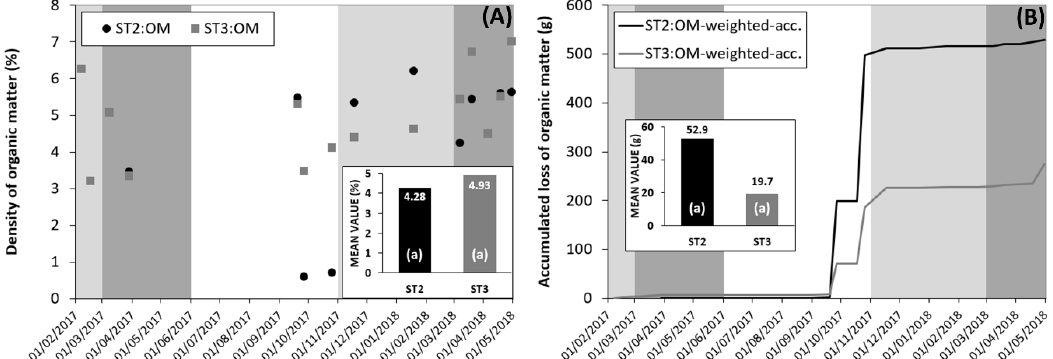
Figure 3. Concentration or density of organic matter (OM) in the sediment (in %) during the test period ( A ). Cumulative total loss of OM (in grams) in the ST2 and ST3 during the test period ( B ). The white, light grey, and grey areas correspond to the periods with low, medium, and high ground vegetation cover, respectively. The same lowercase letters in the inset figures indicate that no significant di ff erence appeared between the ST2 and ST3 at 0.05